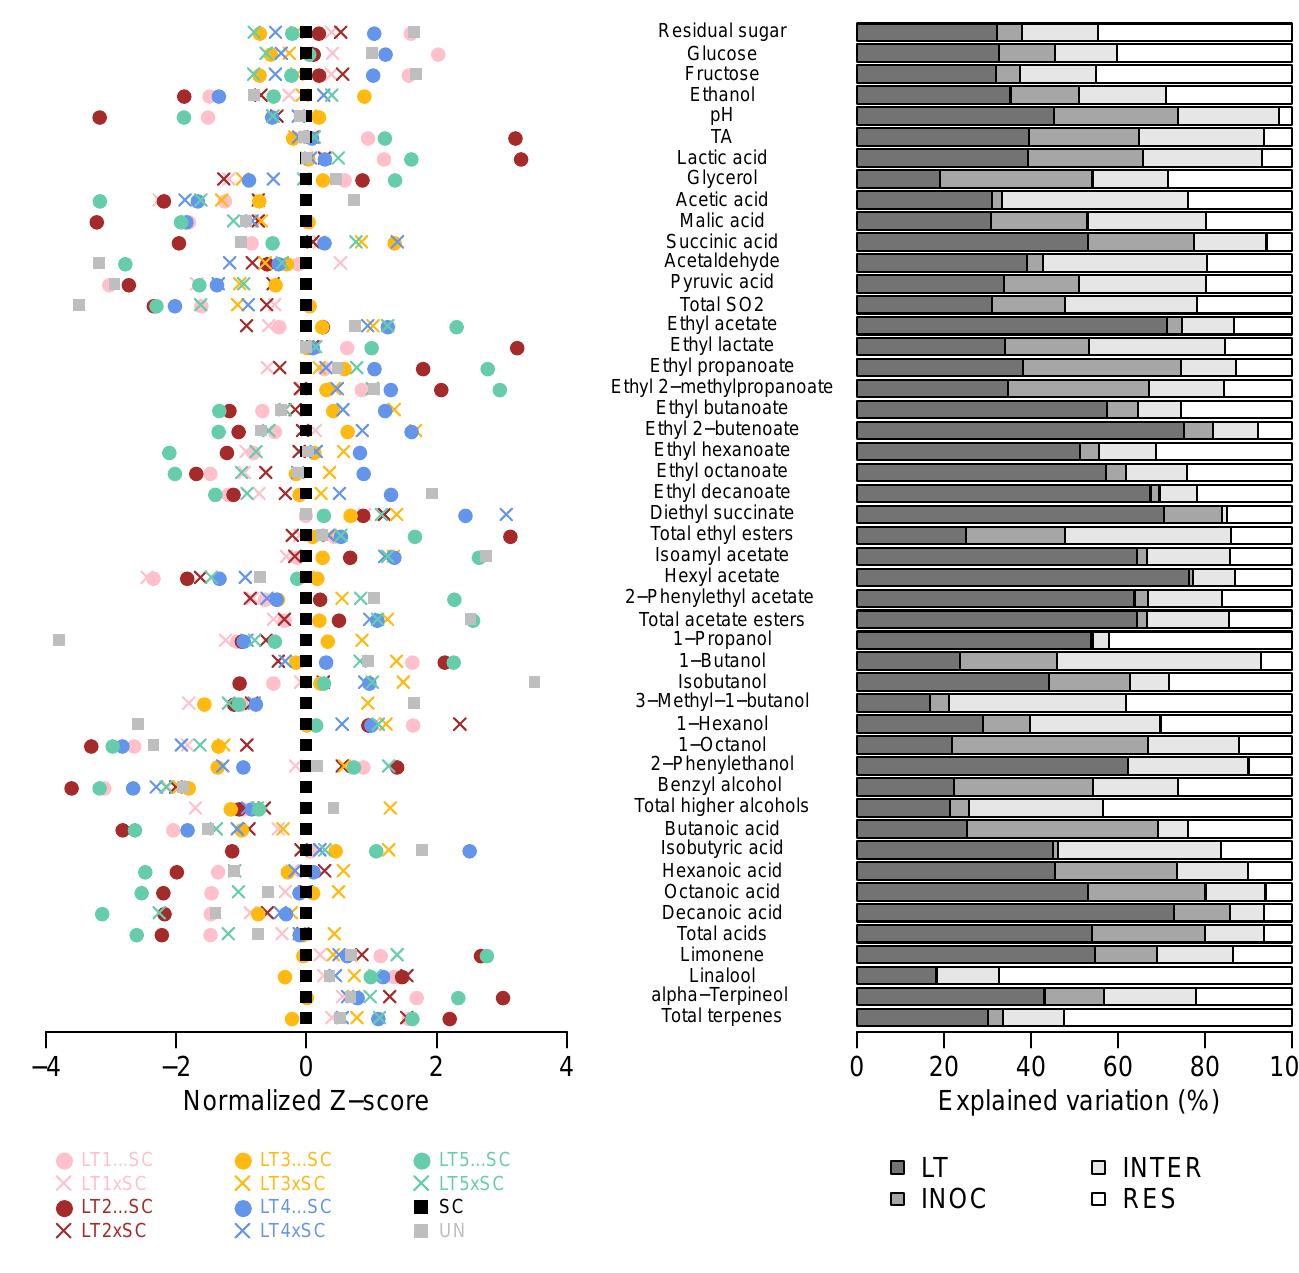
Figure 2. Variation in chemical composition of the experimental Viognier wines. Normalised Z-scores centered to SC wine ( left ). Percentages of variation in LT treatments explained by the LT strain (LT), inoculation modality (i.e., co-inoculation vs. sequential inoculation; INOC), their interaction (INTER) and residual (RES) as determined by 2-way ANOVA ( right ). The abbreviations and colour-coding of yeast treatments correspond to those in Figure